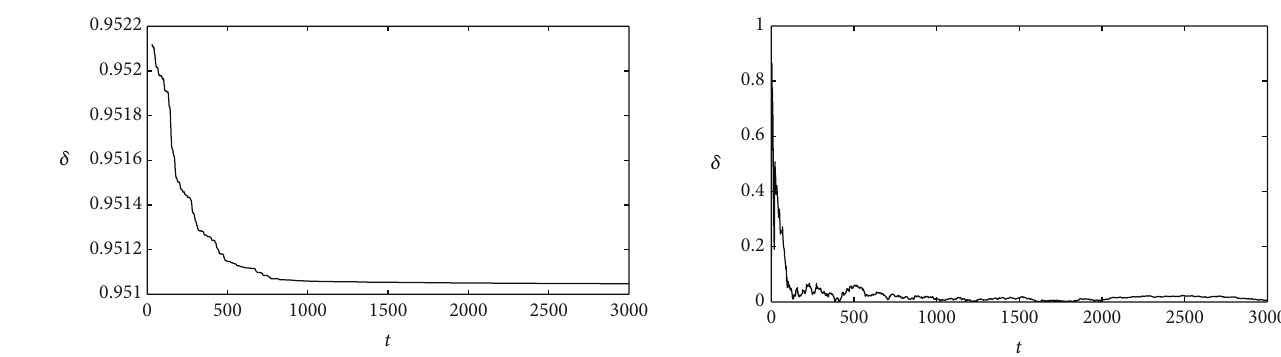
̂ 𝜃 (0) = 1 𝑛 𝑎 +𝑛 𝑏 +𝑛 𝛾 +𝑛 𝑐